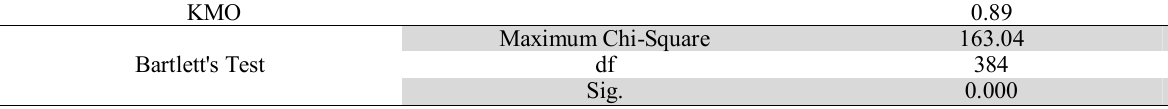
The summary of KMO and Bartlett's Test